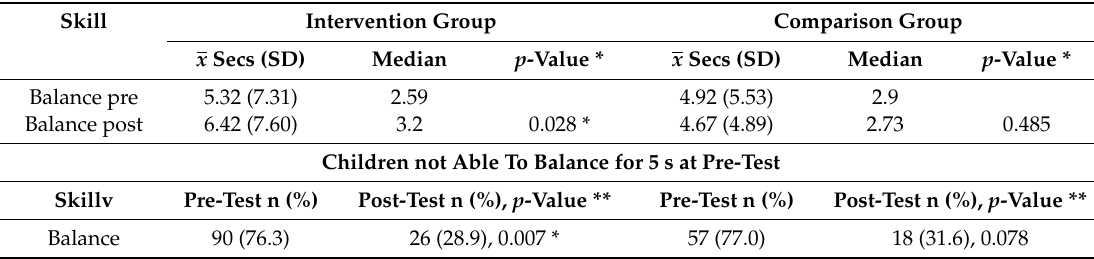
Table 3. Balance on 1 Foot, COMPARISON Study, All 4 Kids © Program ( n = 379).